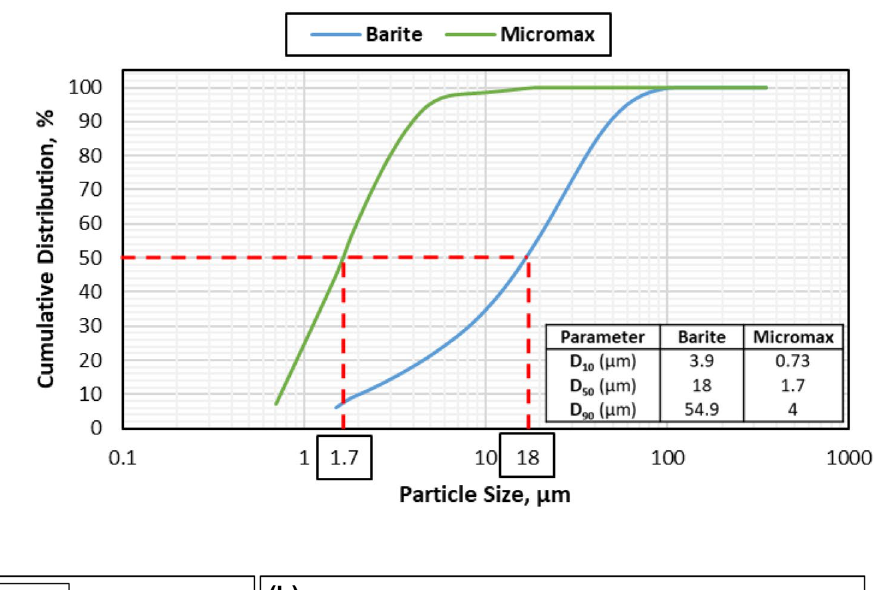
Fig. 4 PSD of the weighting agents